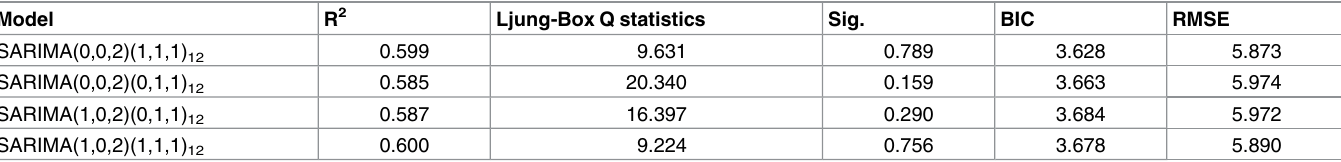
Table 2. Comparisons of univariate SARIMA models. Model R 2